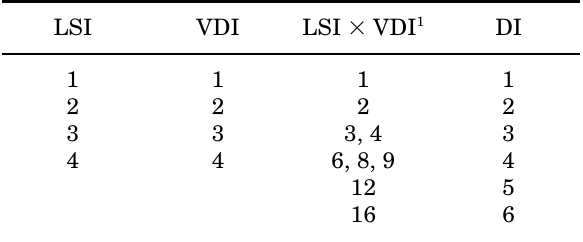
Table 1. The disease index (DI) in melon: the leaf symp- tom index (LSI) (cid:51) the vascular discoloration index (VDI). LSI